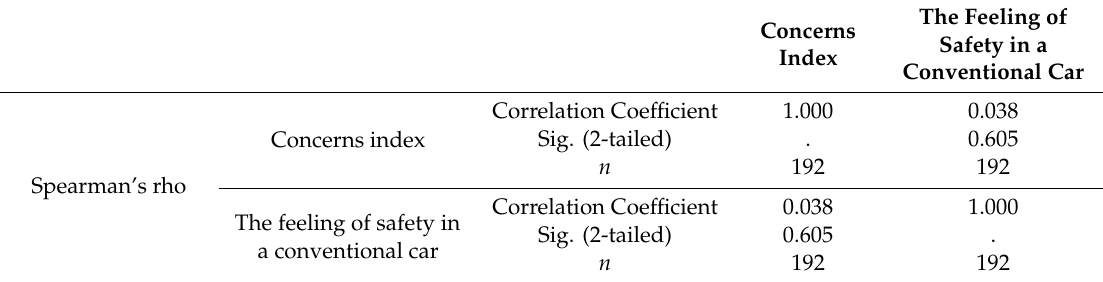
Table 12. Correlations between concerns index and feeling of safety in a conventional car.